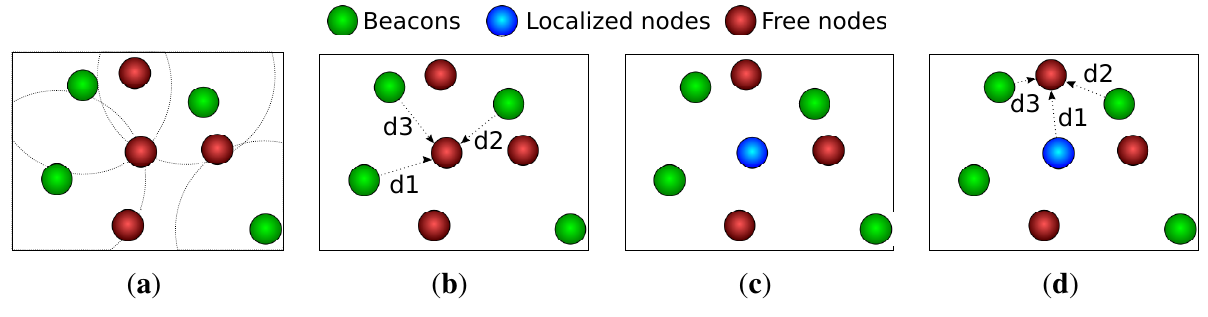
Figure 1. Stages of Recursive Position Estimation . ( a ) Beacon Selection; ( b ) Distance Estimation; ( c ) Position Estimation; ( d ) New